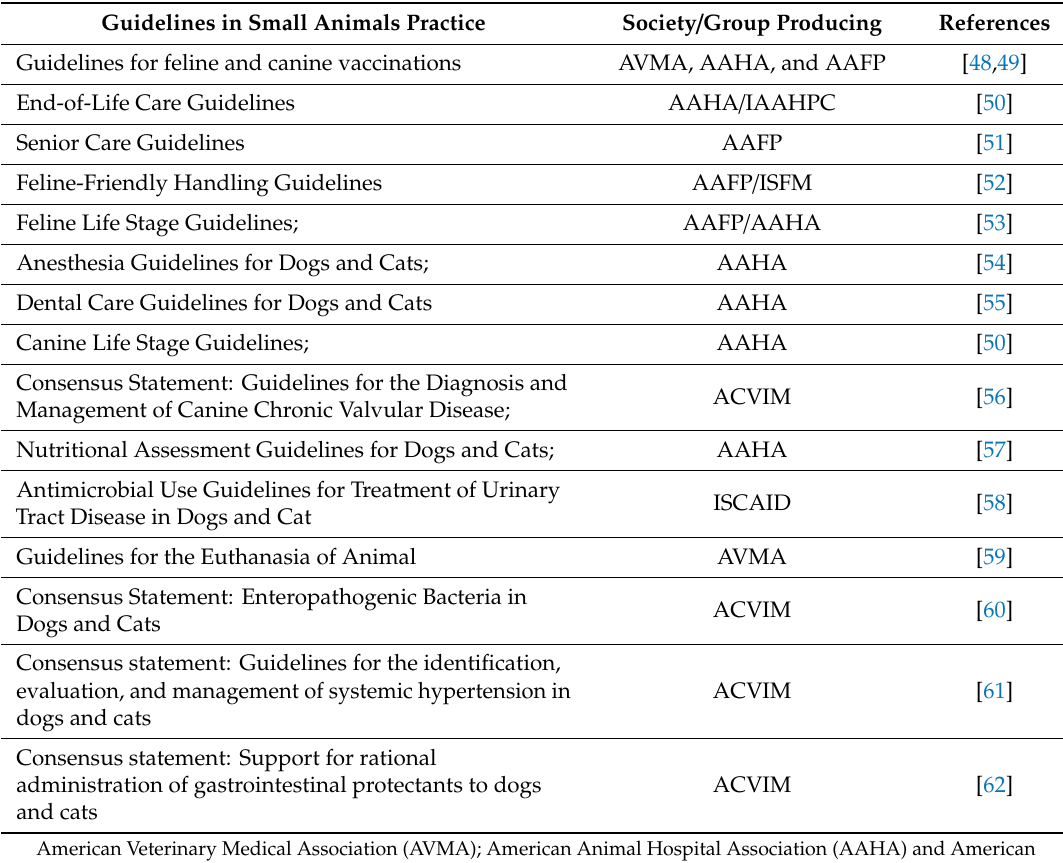
Table 1. List of the most common Guidelines in Veterinary